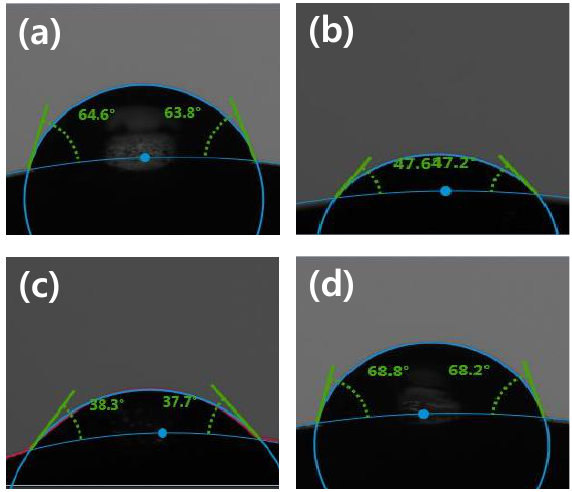
Figure 8. Contact angle image of ( a ) ref sample, ( b ) Ce sample, ( c ) CeP10 sample and ( d ) CeP10_ISO1 sample.